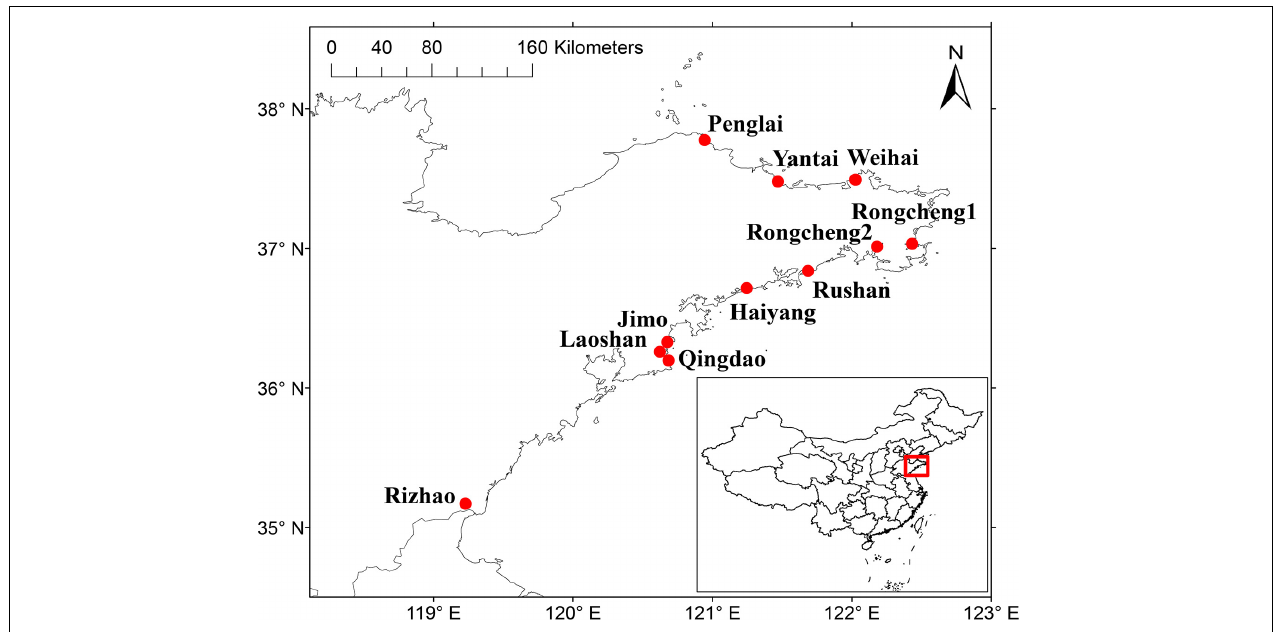
)] in Shandong Peninsula, China. The geographic location of the Shandong Peninsula in China is shown in the inset. FIGURE 1 | The sampling sites [filled circles ( The two maps were created using the DIVA-GIS software (http://www.diva-gis.org), and the sampling sites were added according to GPS record (cid:32)